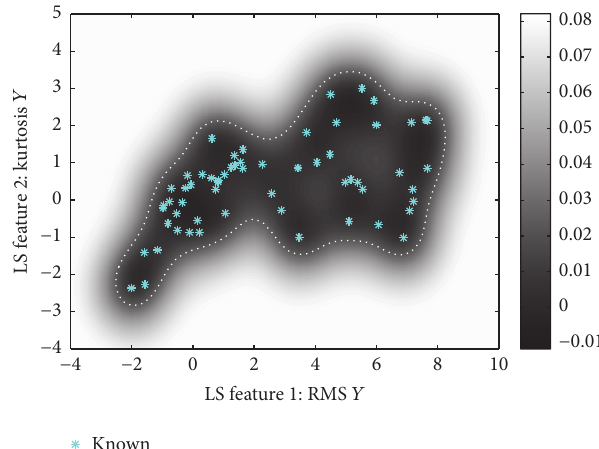
Figure 7: Contour plot of the novelty model after including 𝐹 1 .